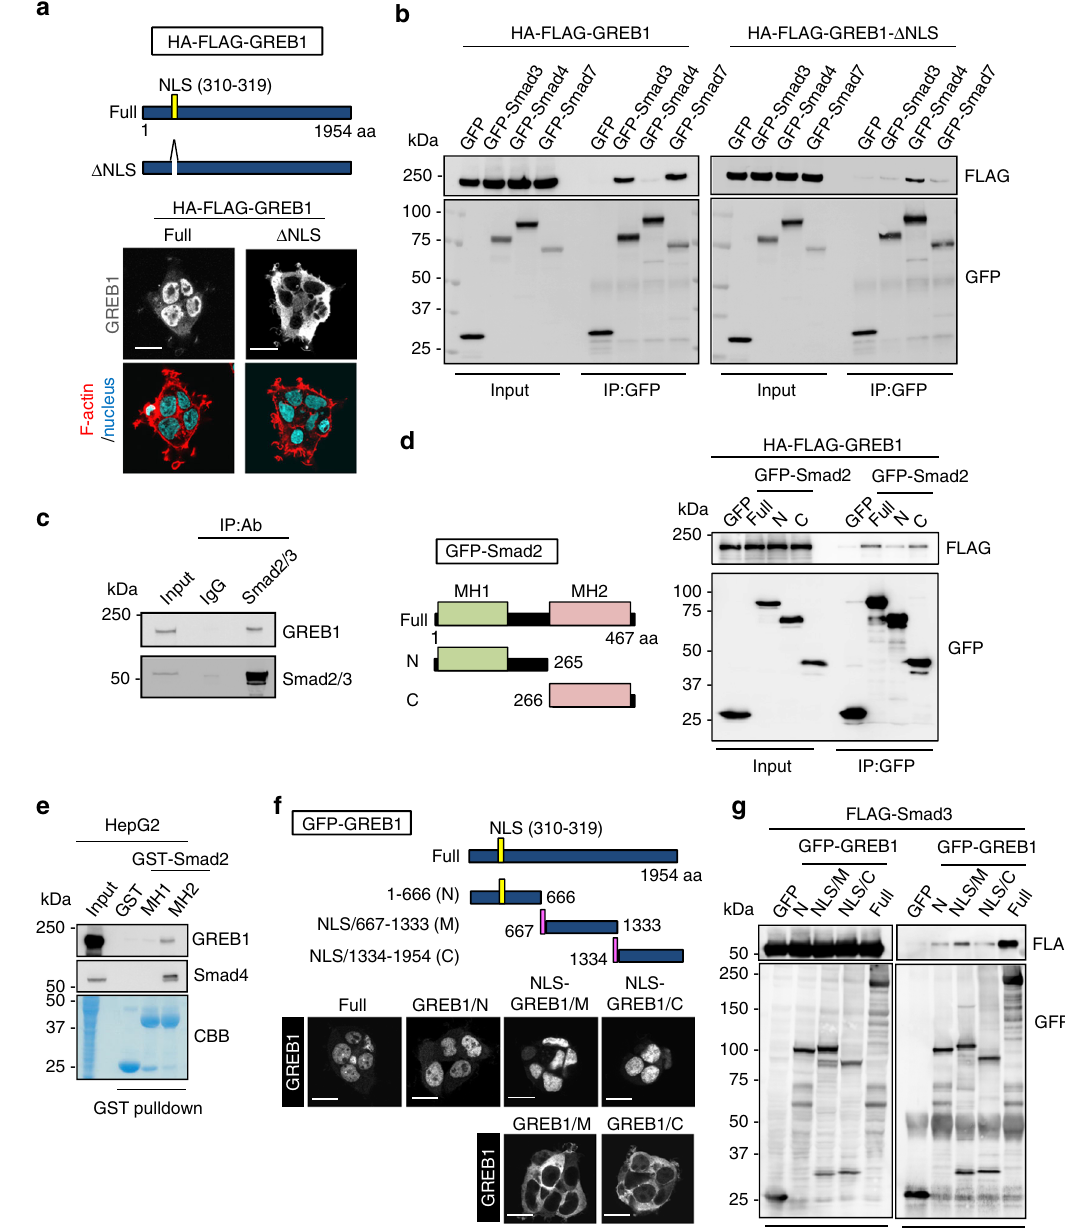
Fig. 3 GREB1 forms a complex with Smad2/3. a Schematic representation of the GREB1 and GREB1- Δ NLS (310 – 319) are shown. X293T cells expressing the indicated proteins were fi xed and stained with anti-FLAG antibody, phalloidin, and Hoechst33342. b Lysates of X293T cells expressing the indicated proteins were immunoprecipitated with anti-GFP antibody, and the immunoprecipitates were probed with the indicated antibodies. c Lysates of HepG2 cells were immunoprecipitated with anti-Smad2/3 antibody and the immunoprecipitates were probed with the indicated antibodies. d Schematic representation of the deletion mutants of Smad2 used in this study is shown. Lysates of X293T cells expressing HA-FLAG-GREB1 and GFP-Smad2 mutants were immunoprecipitated with anti-GFP antibody and the immunoprecipitates were probed with the indicated antibodies. e Lysates of HepG2 cells were precipitated with recombinant GST, GST-Smad2/MH1, or GST-Smad2/MH2 proteins and the precipitates were probed with the indicated antibodies. f Schematic representation of three deletion mutants (N, M, and C) of GFP-GREB1 is shown. HepG2 cells expressing deletion mutants of GFP-GREB1 were fi xed and stained with anti-GFP antibody. g Lysates of X293T cells expressing FLAG-Smad3 and GFP-GREB1 mutants were immunoprecipitated with anti- GFP antibody and the immunoprecipitates were probed with the indicated antibodies. Scale bars in a and f , 20 μ overexpression did not affect Axin2 mRNA expression (Fig. 4h). Consistent with the observation that TGF β signaling suppresses AFP and DLK1 in rat fetal hepatocytes and HCC cells 20,21 , TGFBR T204D expression in HepG2 cells indeed decreased the levels of AFP and DLK1 mRNAs; Smad2/3 knockout rescued GREB1 knockdown-induced decrease in AFP expression